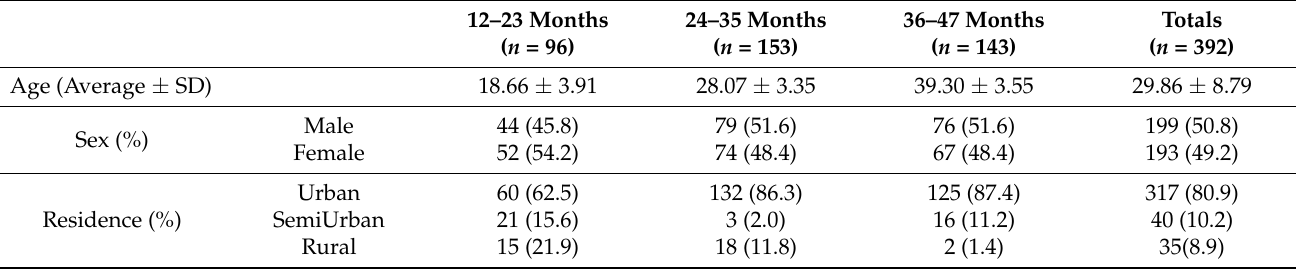
Table 1. Sociodemographic characterization of the 392 Portuguese